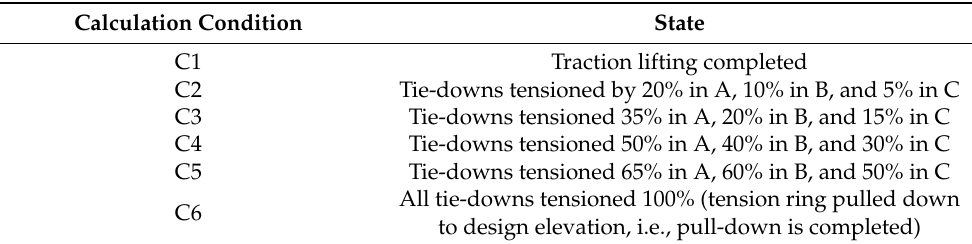
Table 16. Calculation conditions during proportional section tension.